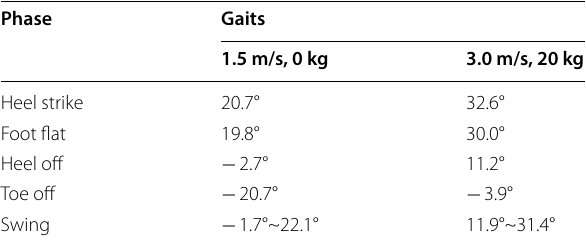
Table 5 Motion characteristics of the mechanism in different phases